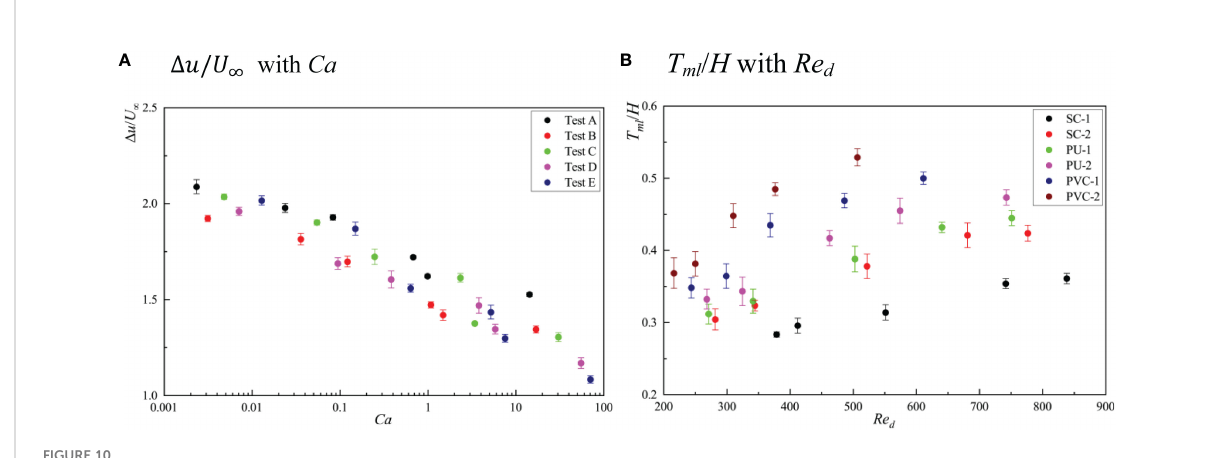
FIGURE 10 Relationships of D u / U ∞ and T ml / H with Ca (A) and Re d (B)